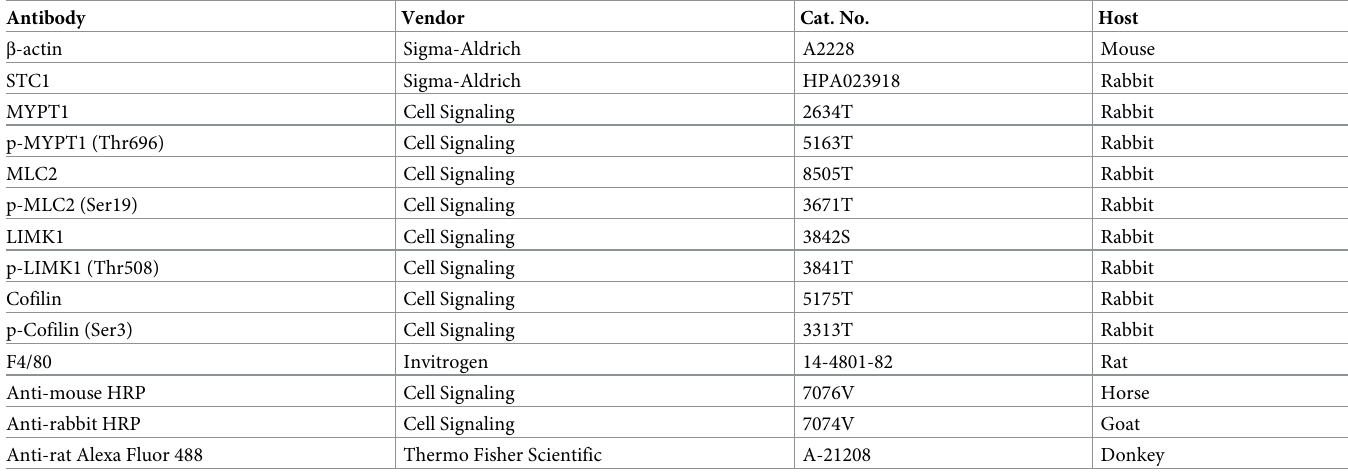
Table 2. List of antibodies